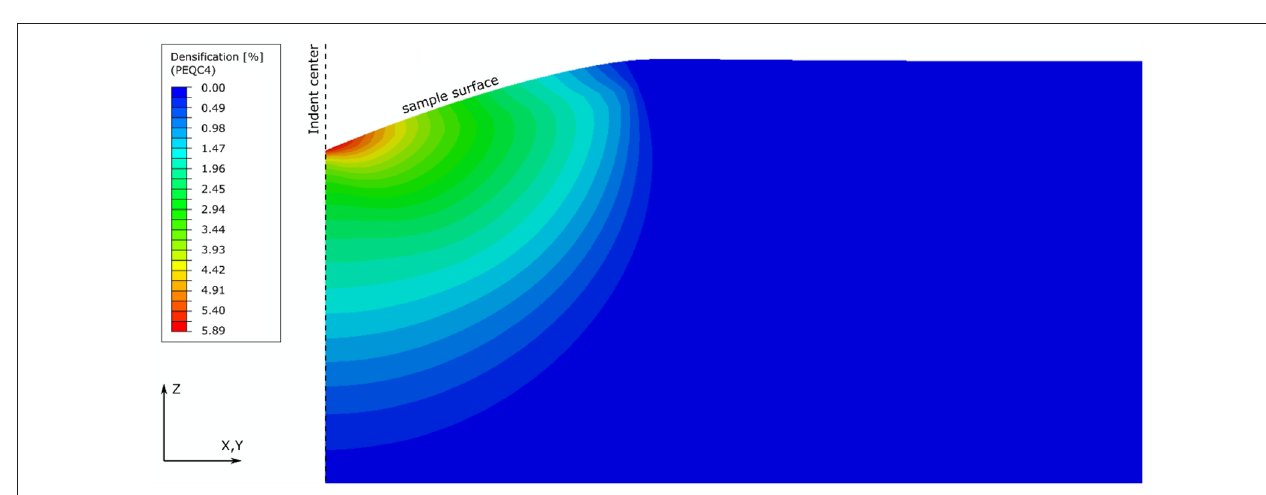
FIGURE 11 | FEA densification field for the system with constant 60 mol% SiO 2 , beneath the residual impression of a Berkovich equivalent conical indentation. As the indenter shape is self-similar, the shape of the densification field is independent from indentation depth. Therefore, no scale is required for the axes X,Y,Z. Densification is exported from ABAQUS using the PEQC4